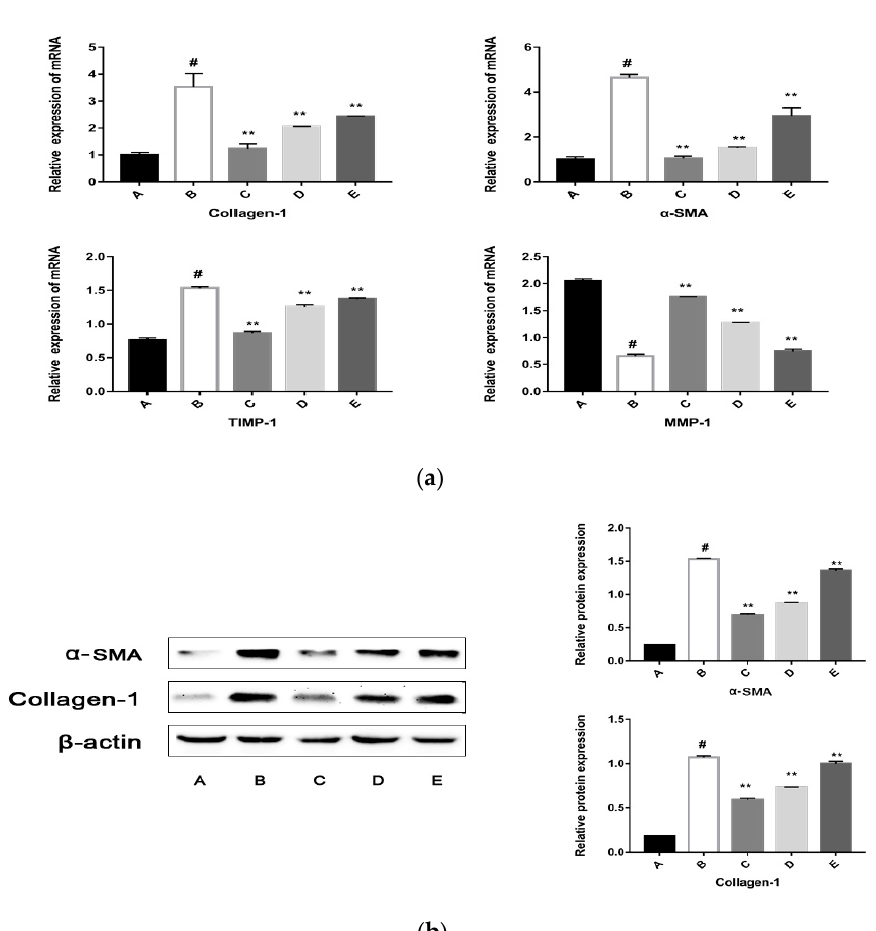
Figure 6. Effects of the CPhG liposomes on the expressions of collagen-1, α -SMA, TIMP-1, and MMP-1 in HSCs. ( a ) The mRNA expression of collagen-1, α -SMA, TIMP-1, and MMP-1 in HSCs (RT-PCR assay). ( b ) The protein expression of collagen-1 and α -SMA. A, the control group; B, the rrPDGF-BB treated group; C, the rrPDGF-BB + CPhG liposome 29.45 µg/mL treated group; D, the rrPDGF-BB + CPhG liposome 14.72 µg/mL treated group; E, the rrPDGF-BB + CPhG liposome 7.36 µg/mL treated group; Data are expressed as the mean ± SD. ** p < 0.01, significantly different compared to the rrPDGF-BB-activated HSCs group. # p < 0.05, significantly different compared to the control group. β -actin was used as an internal control.